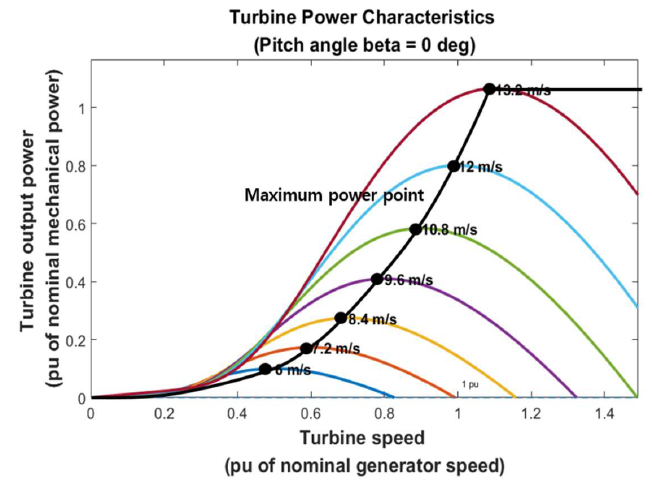
Figure 2. Maximum Power Point Tracking with variable wind speeds.